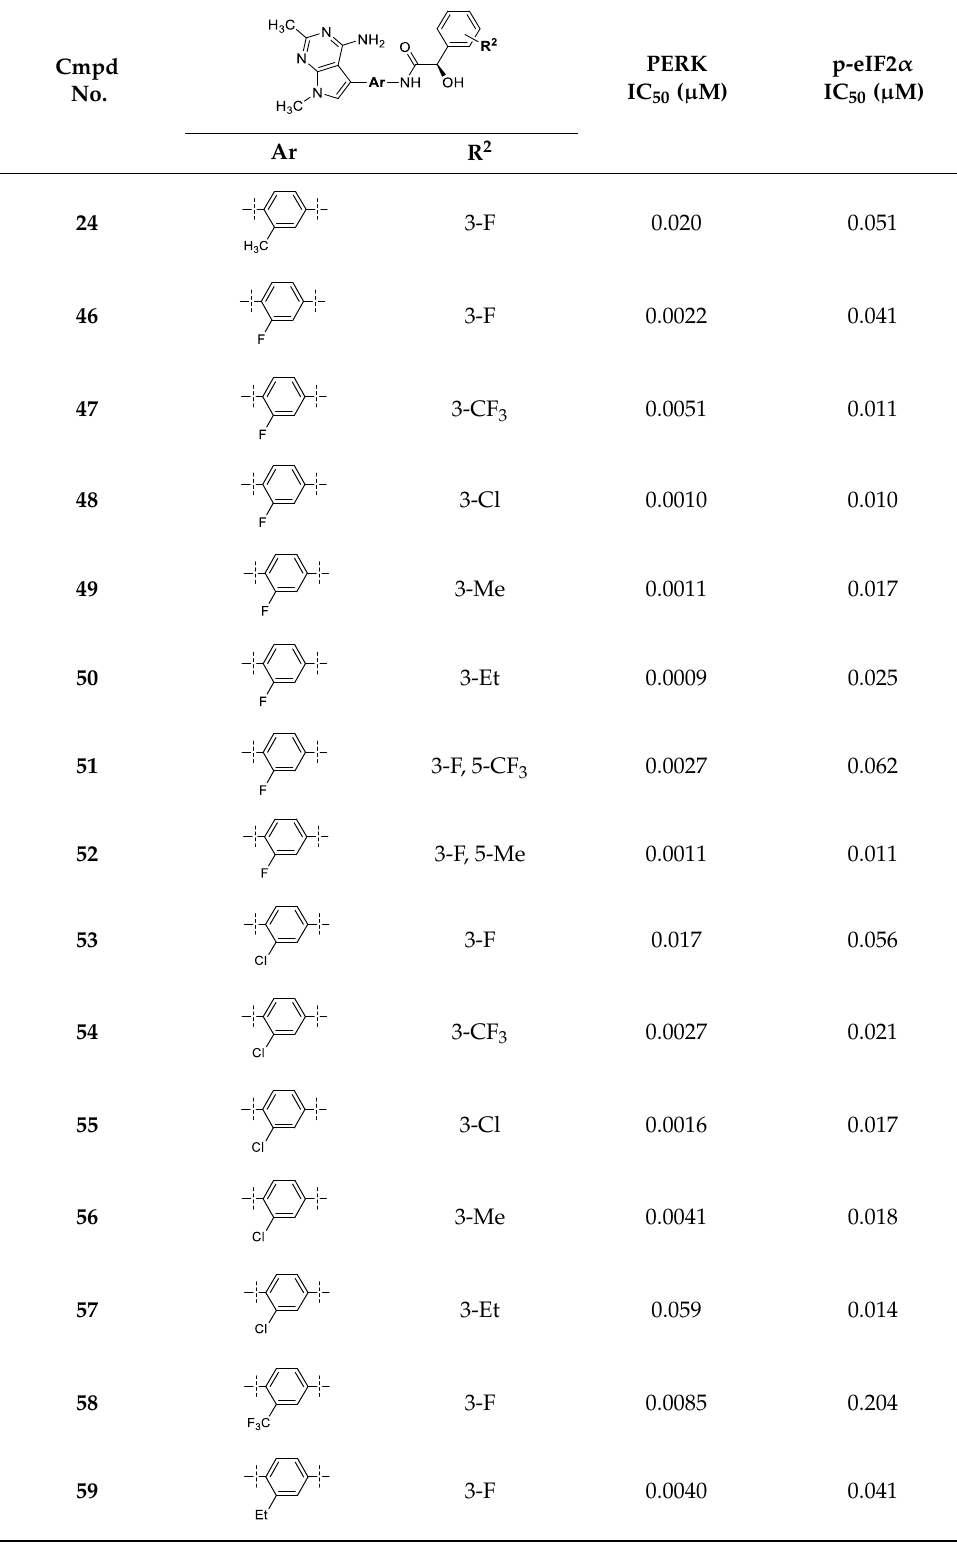
Table 3. In vitro data of PERK inhibitors with proximal and terminal ring modifications.